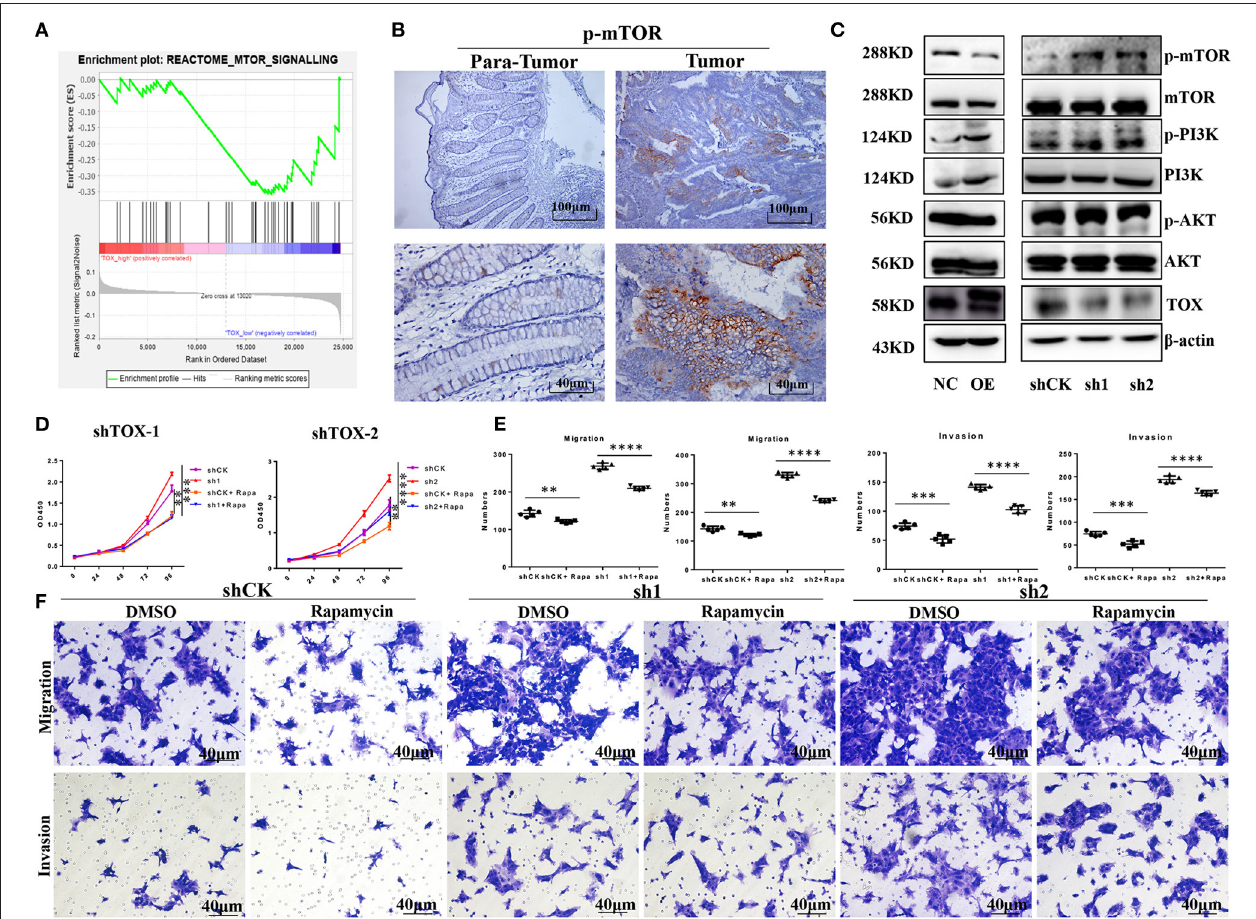
FIGURE 5 | Rapamycin partly rescues the aggressive phenotype of TOX-deficient cells. (A) GSEA was used to analyze the mTOR signaling pathway in CRC patients ( n = 588). (B) IHC shows the expression of p-mTOR in CRC ( n = 40). (C) Western blots showed the expression of p-PI3K, PI3K, p-AKT, AKT, mTOR, and p-mTOR in PLVX-Flag-TOX SW1116, PLVX-Flag SW1116 cells, shCK HCT116, shTOX-1 (sh1), and shTOX-2 (sh2) HCT116 cells. (D) Cell proliferation was measured in shCK HCT116 and shTOX HCT116 cells with or without rapamycin treatment by CCK8. (E,F) Cell migration and invasion were measured with or without rapamycin in shCK HCT116, shTOX-1 (sh1), and shTOX-2 (sh2) HCT116 cells by Transwell. Each experiment was repeated three times. ** p < 0.01,*** p < 0.001,**** p <